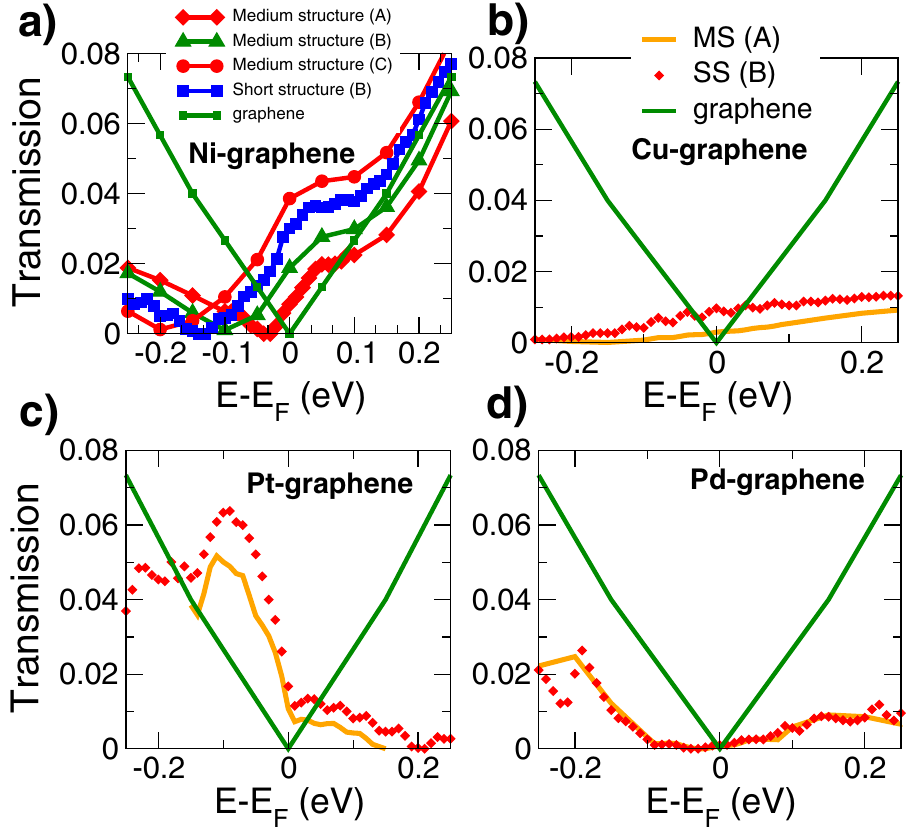
Figure 5. Transmission simulation of different contacts. ( a ) Transmission coefficient as a function of energy obtained with PWCOND for nickel-graphene contacts for different cutting points, corresponding to those indicated in Fig. 2 and compared with the transmission of the ideal graphene monolayer (green diamonds). It is clear that the transmission coefficient and the conductance strongly depend on the cut point. ( b–d ) Transmission for graphene-metal systems obtained with PWCOND for different metals (Cu,Pd,Pt) compared with the transmission of the ideal graphene monolayer (in green), for the short structure at point B (SS B, in red) and for the medium structure at point A (MS A, in orange).